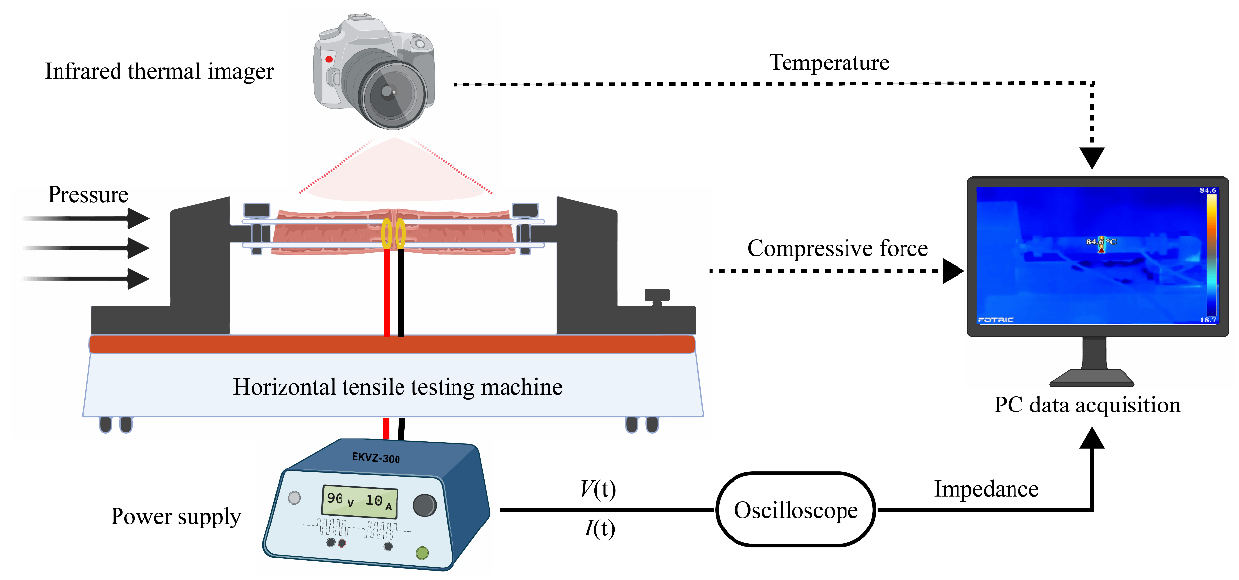
Figure 1. Tissue welding system with real-time monitoring impedance, pressure, and temperature. High-frequency electric field welding technology uses electricity and pressure to make two separated tissues quickly restore continuity. Two 100 mm long segments of small intestine tissue are turned inward over the ring electrodes, allowing the serosa–serosa anastomosis. The power supply delivers electrical energy to the welding area through the ring electrodes. The voltage and current are recorded by an oscilloscope and used to calculate dynamic impedance. The horizontal tensile testing machine applies pressure to the welding area through the column carrier and records the compressive force changes during the welding process. The infrared thermal imaging camera can monitor the temperature distribution on the weld surface during the welding process.